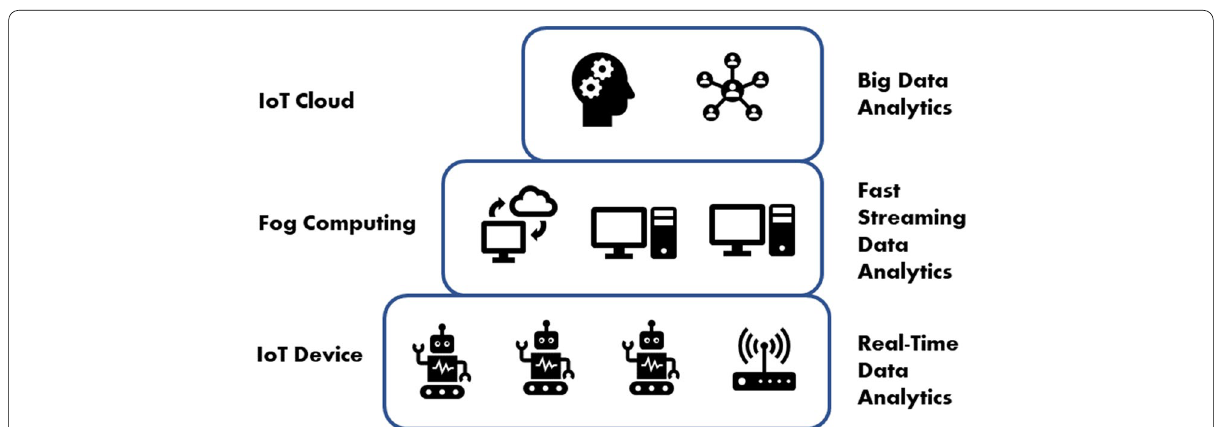
Fig. 2 Three levels of IoT system. As the top‑level, IoT employing a cloud system associated with big data analytics. Fog computing resides in the middle, equipped with fast streaming data analytics. At the bottom level, IoT devices such as sensors are located with consecutive temporal data requiring real‑time data